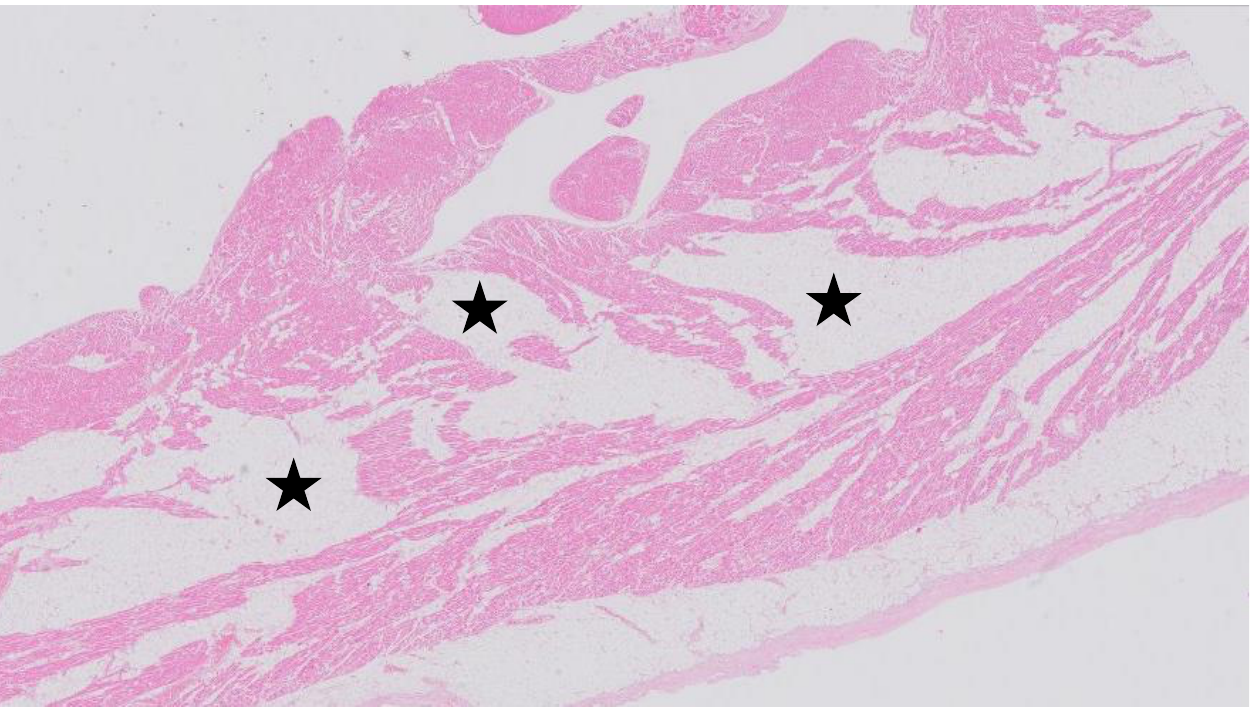
Figure 1. Hematoxylin- and Eosin-stained section of the right ventricle of the heart with extensive fatty changes of the myocardium, partly subendocardial, with only minor fibrosis. Asterisk indicates fatty tissue.